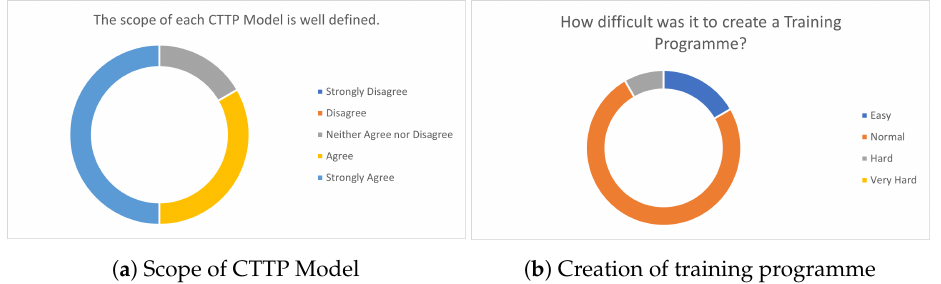
Figure 18. Participants response to the CTTP Model’s clear Scope ( a ) and the Training Programme’s creation difficulty ( b ).